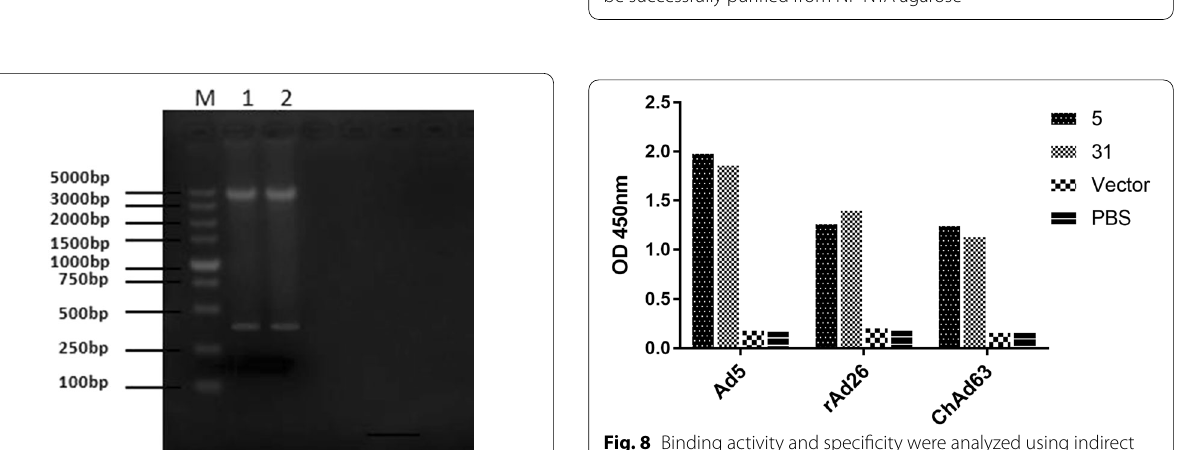
Fig. 8 Binding activity and specificity were analyzed using indirect ELISA. The recombinant sdAbs 5 and 31 showed strong binding activity to human adenovirus Ad5, rAd26, and ChAd63 viruses in ELISAs at a concentration of 5 μg/ml. Protein extracts from E. coli transformed with the empty pET-25b ( ) vector were used as a + negative control, and PBS solution was used as a blank